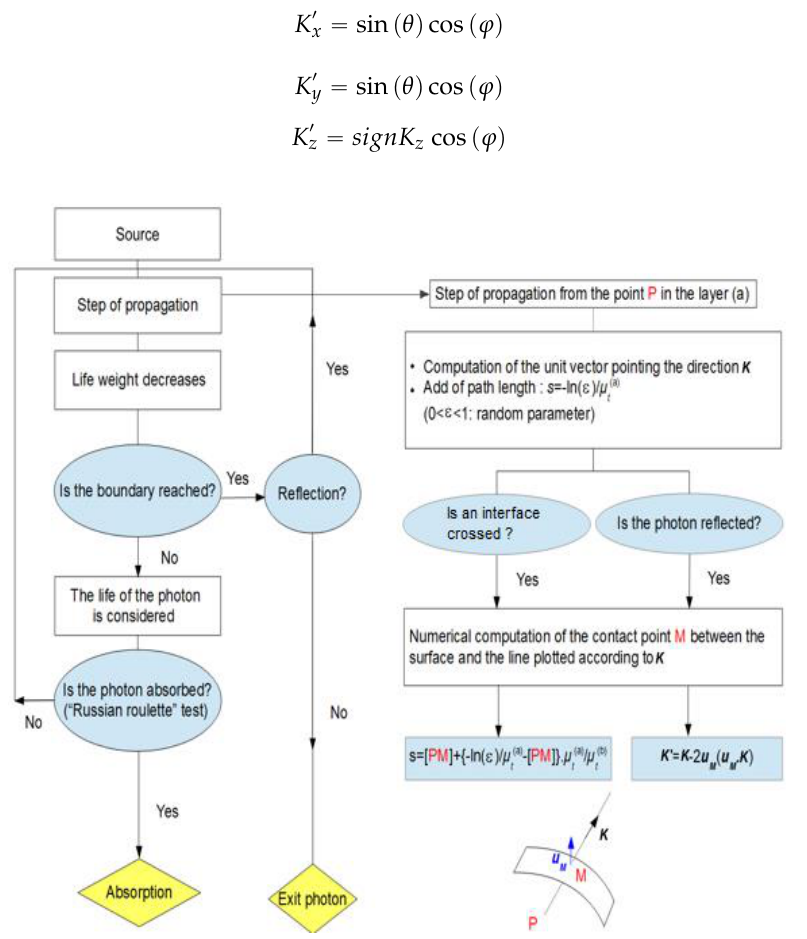
Figure 2. Flowchart of the fundamental steps of the Monte Carlo simulations